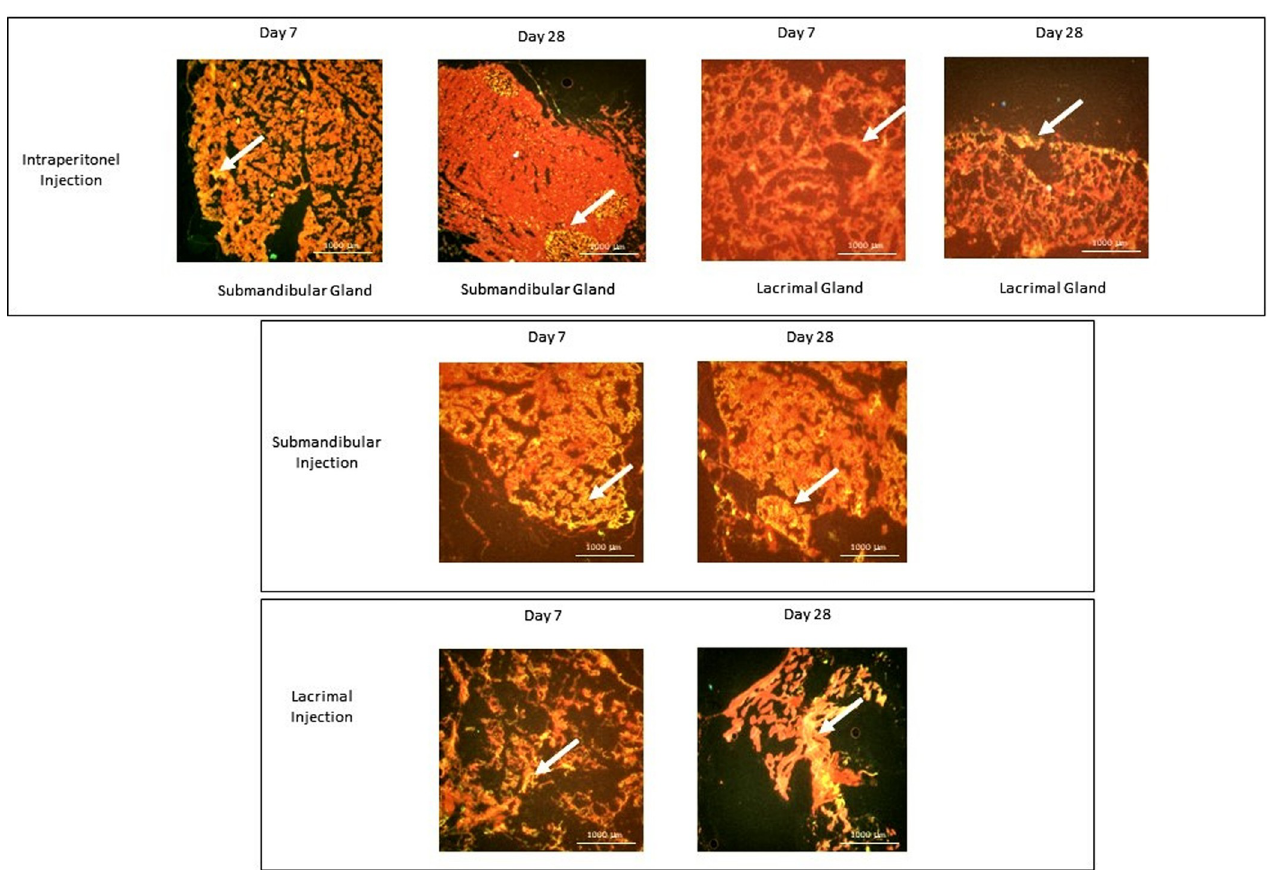
Fig 7. Homing of DFMSCs in submandibular and lacrimal glands in SS mouse model. Quantum dot 655 (Qdot-655) labeled cells were analyzed with a fluorescence microscope in the glandular tissues of the SS murine model on the 7 th and 28 th days after intraperitoneal, and local injections of DFMSCs. Qdot labeled DFMSCs were located in submandibular and lacrimal glands within 7 days when injected locally. Intraperitoneally injected DFMSCs migrated preferentially to submandibular glands in the first 7 days and localized as foci in the exocrine gland for up to 28 days.